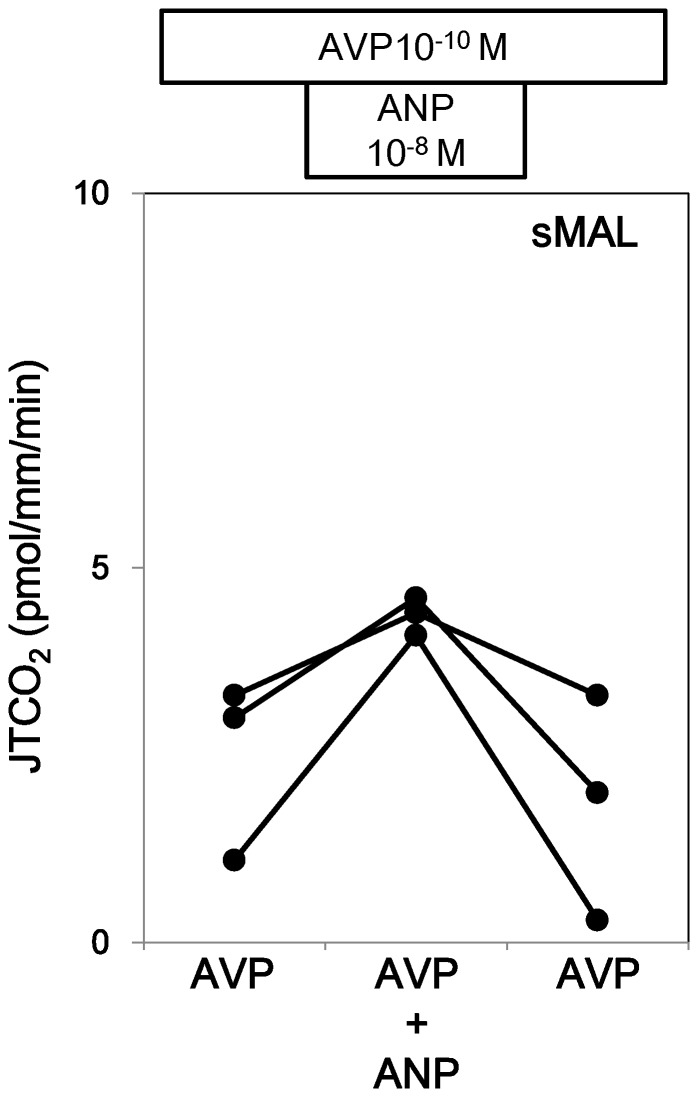
Effect of ANP on HCO3
− transport in the presence of AVP in sMALs.ANP at the concentration of 10−8 M stimulated HCO3
− reabsorption in the presence of 10−10 M AVP in sMALs.